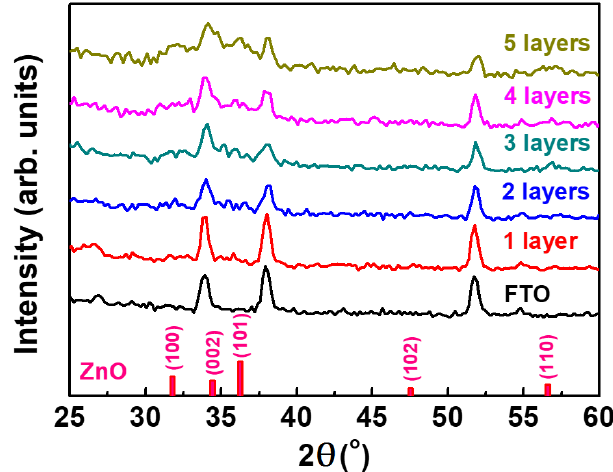
Figure 3. The XRD patterns of various ZnO electron transport layers, baking at 180 °C.